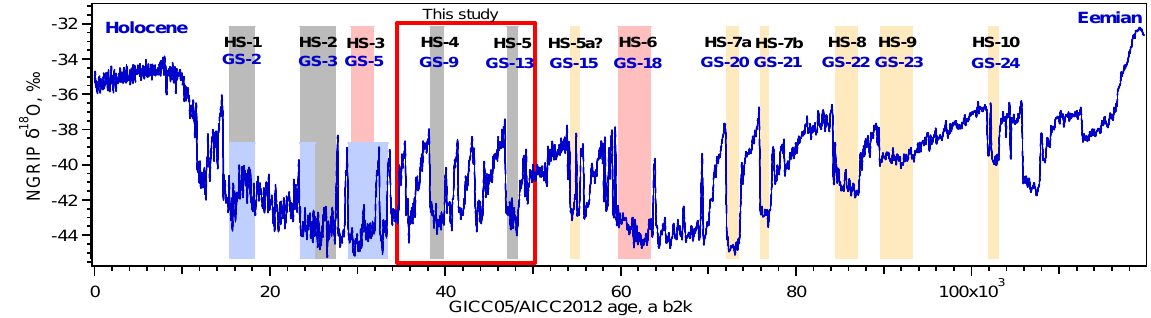
Figure 1. Dansgaard–Oeschger (the warm phases being marked as Greenland Interstadials, GI) and Heinrich Stadials (HSs) during the last glacial period. Blue line: NGRIP δ 18 O, ‰(NGRIP members, 2004), on the GICC05 timescale back to 60ka b2k (Appendix A1) and AICC2012 beyond (Bazin et al., 2013; Veres et al., 2013). Coloured areas: Heinrich Stadials. Grey: HS-1, HS-2, HS-4 and HS-5: occurrence of a major Heinrich event of mainly Laurentide origin. Pink: HS-3 and HS-6, major events of mainly European origin (see text for references). Yellow: HS-5a and HS-7 to HS-10, occurrence of a minor IRD event of Laurentide origin recorded in the West Atlantic (Rashid et al., 2003; Rasmussen et al., 2003). Blue: periods of low salinity corresponding to freshwater input on the Celtic Margin (Eynaud et al., 2012).